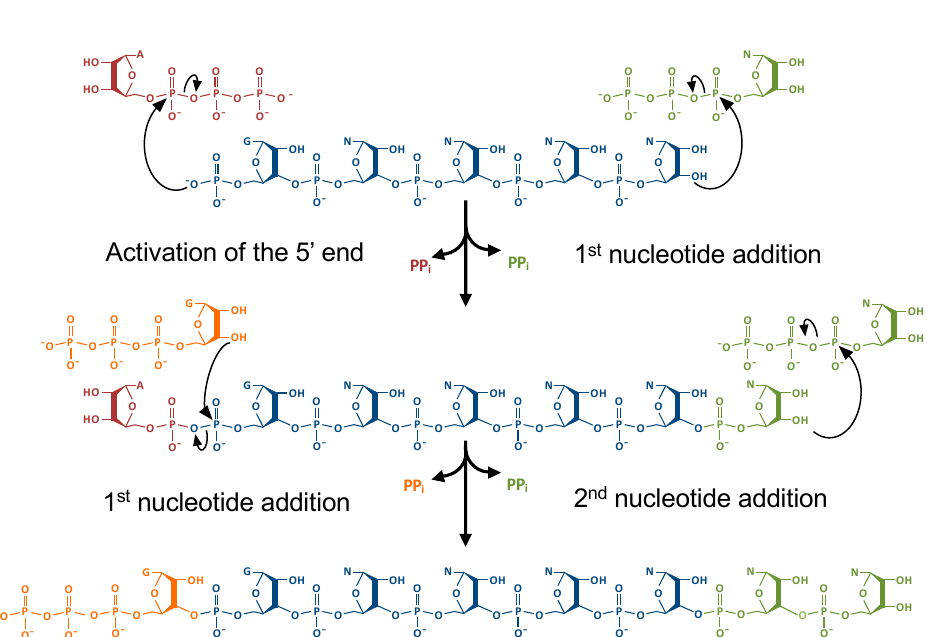
Figure 1. Forward 5 ′ to 3 ′ and reverse 3 ′ to 5 ′ polymerization are mechanistically similar. Ligation of a nucleotide to an RNA strand utilizes chemical energy that has been stored in the high-energy phosphoanhydride bonds in the nucleotide triphosphate. During forward polymerization, the triphosphate of the incoming nucleotide is hydrolyzed and provides energy to form a phosphodiester bond. For reverse polymerization, an initial activation step of a monophosphorylated RNA 5 ′ end (such as by adenylylation, which is shown here) is required; subsequent nucleotide additions utilize energy derived from hydrolysis of the phosphodiester bond of the RNA 5 ′ -end triphosphate.